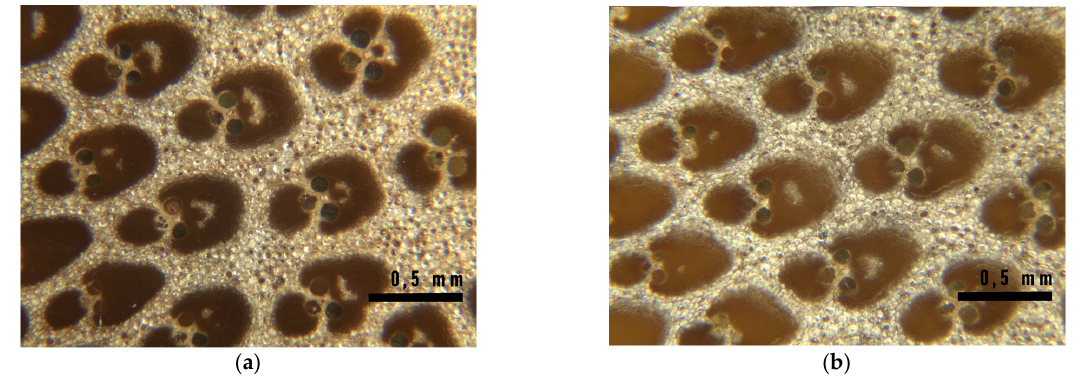
Figure 15. Optical microscopy images showing holes in the fiber island of the vascular bundles of the middle part of the culm wall for natural ( a , on the left) and treated ( b , on the right) samples after 192 hours of exposure to UV irradiation.